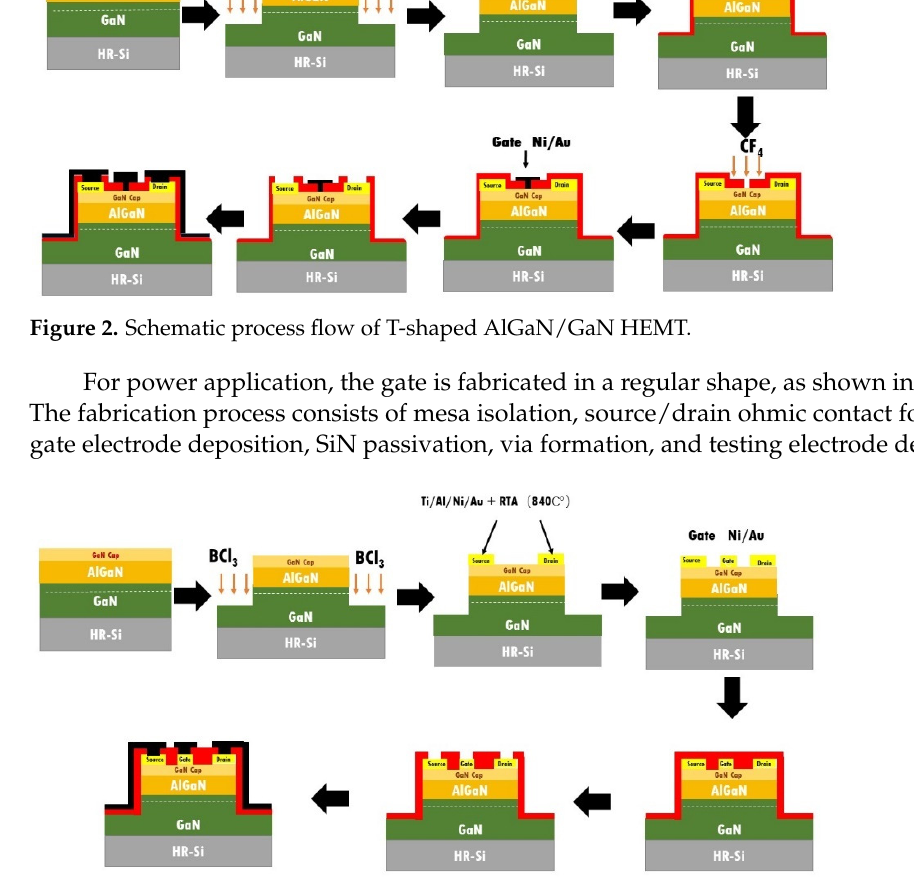
Figure 3. Schematic process flow of regular AlGaN/GaN HEMT.